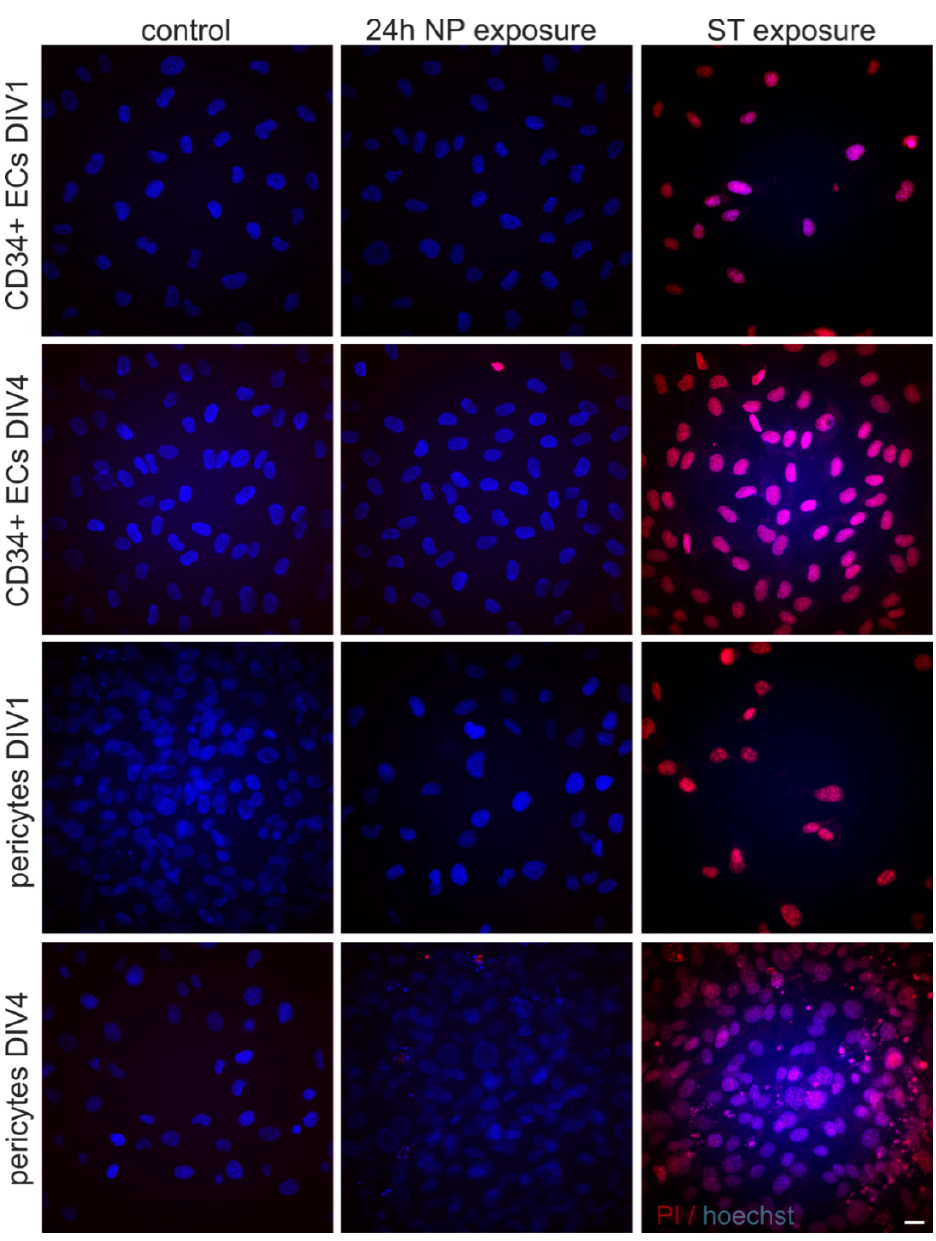
Figure A1. Images showing Hoechst and propidium iodide (PI) stainings of CD34+ECs and pericytes at DIV1 and DIV4. Representative INCell analyser images show PI positive staining only after staurosporine exposure for both CD34+ECs and pericytes. Scale bars: 10 μ m. Cell nuclei were counterstained with Hoechst (blue). DIV = day in vitro.